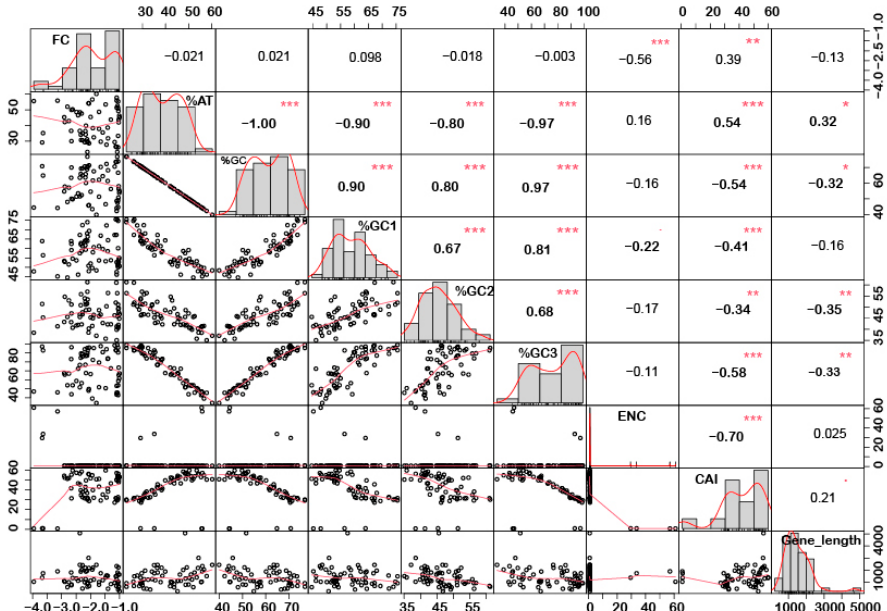
Figure 3. Correlation analysis among nucleotide composition, gene expression, gene length, ENC, and CAI of downregulated genes under biotic stress. A significant negative correlation was observed between gene expression and ENC, while %GC content (at the first, second and third codon positions) was negatively correlated with ENC and gene length while positively correlated with CAI. Asterisk indicate significant correlation, as *** with a p -value < 0.001, ** with p -value < 0.05 and * with a p -value < 0.01. FC = fold change; ENC = effective number of codons; CAI = codon adaptation index.